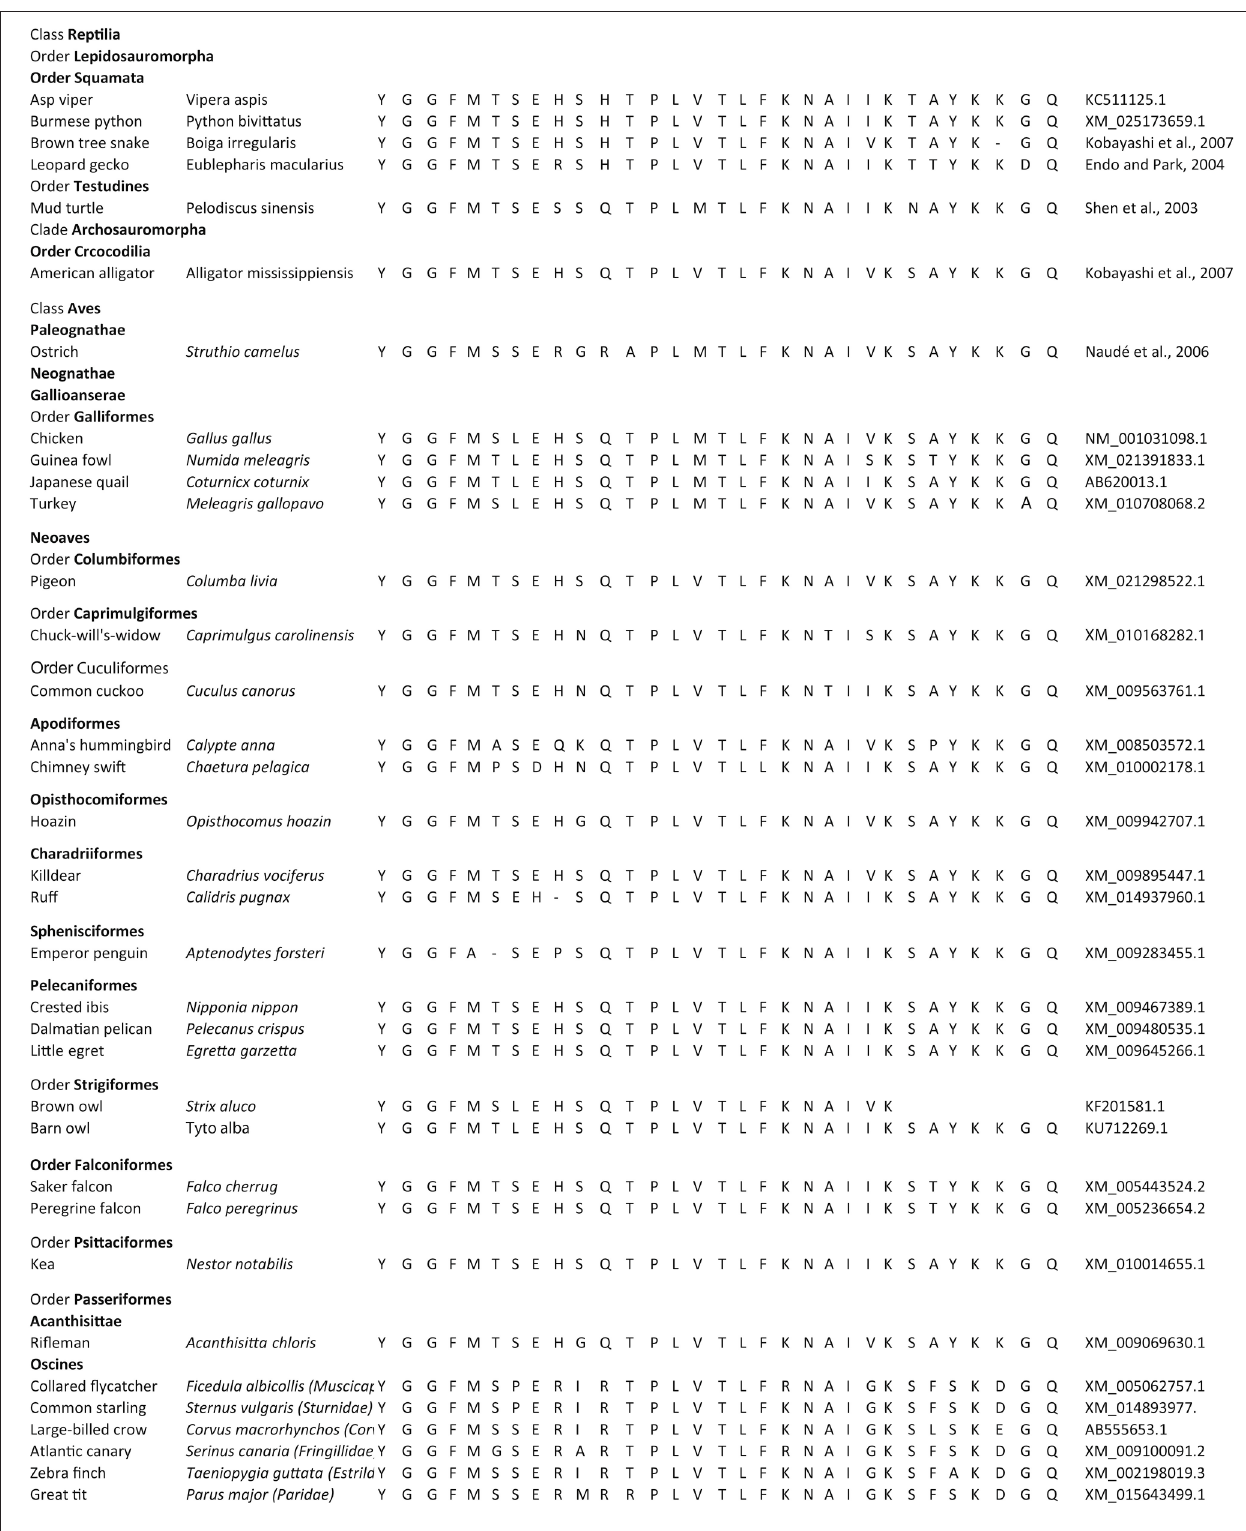
FIGURE 3 | Evolution of β -endorphin. Comparison for the structures of β -endorphin in reptiles and birds.